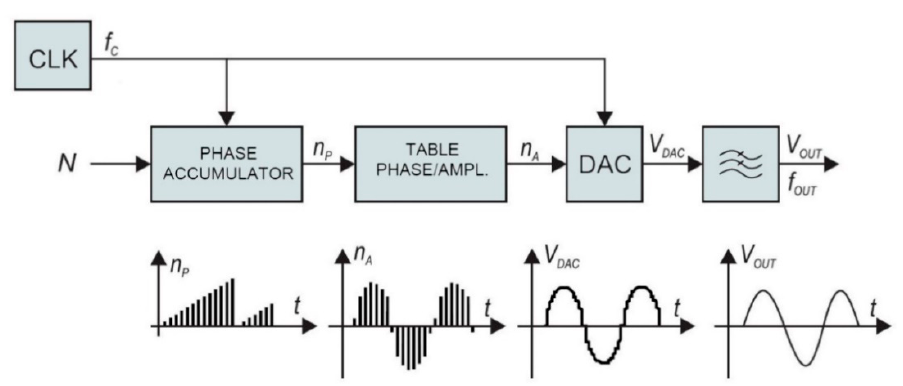
Figure 5. Employed frequency synthesizer.